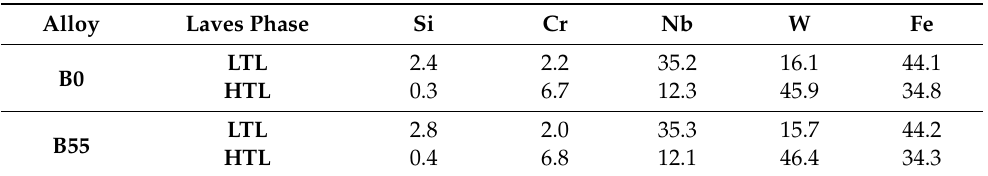
Table 2. Calculated chemical composition of the occurring Laves phases at 650 °C (in wt. %; ThermoCalc, database TCFE8).